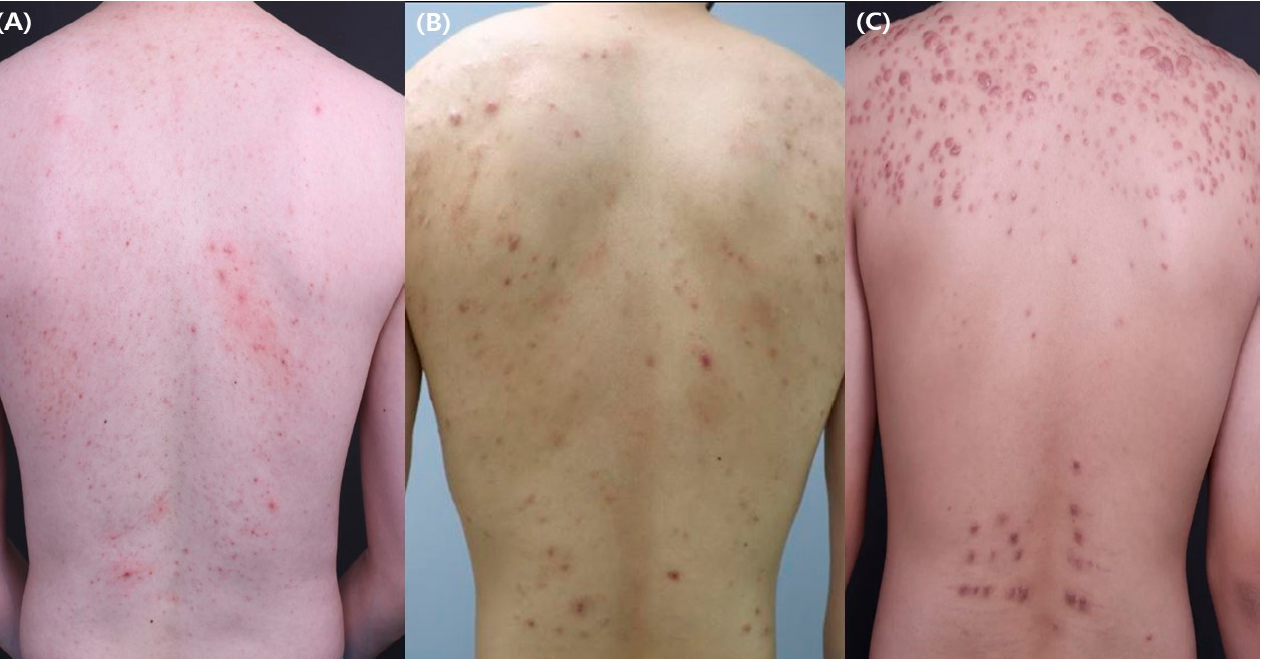
Figure 1. Clinical manifestations of truncal acne. ( A , B ) Truncal acne. ( C ) Truncal acne with severe scarring.